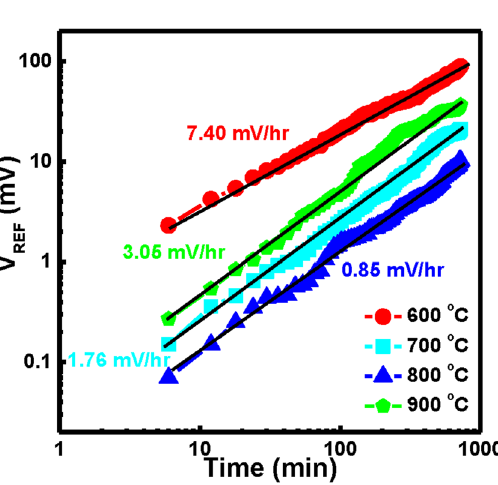
Figure 6. Hysteresis voltages during the pH loop 7 → 4 → 7 → 10 → 7 of CeY x O y EIS devices that had been prepared with annealing at various temperatures.